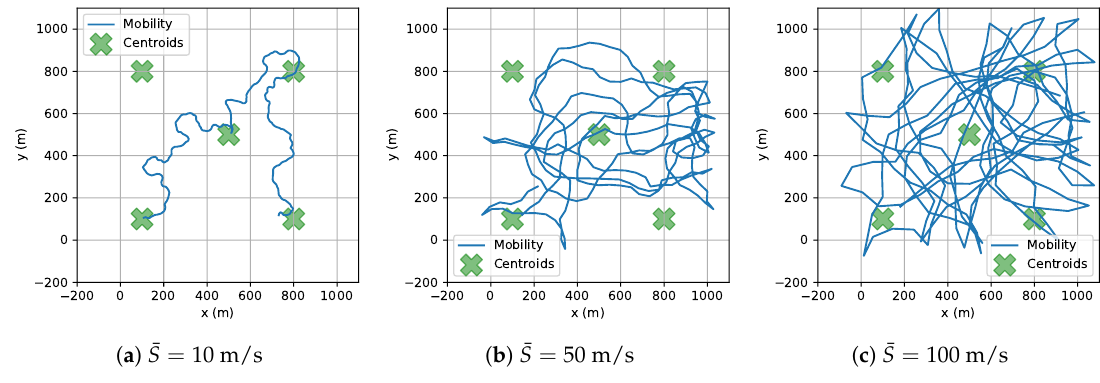
Figure 5. Varying α values for RSSGM